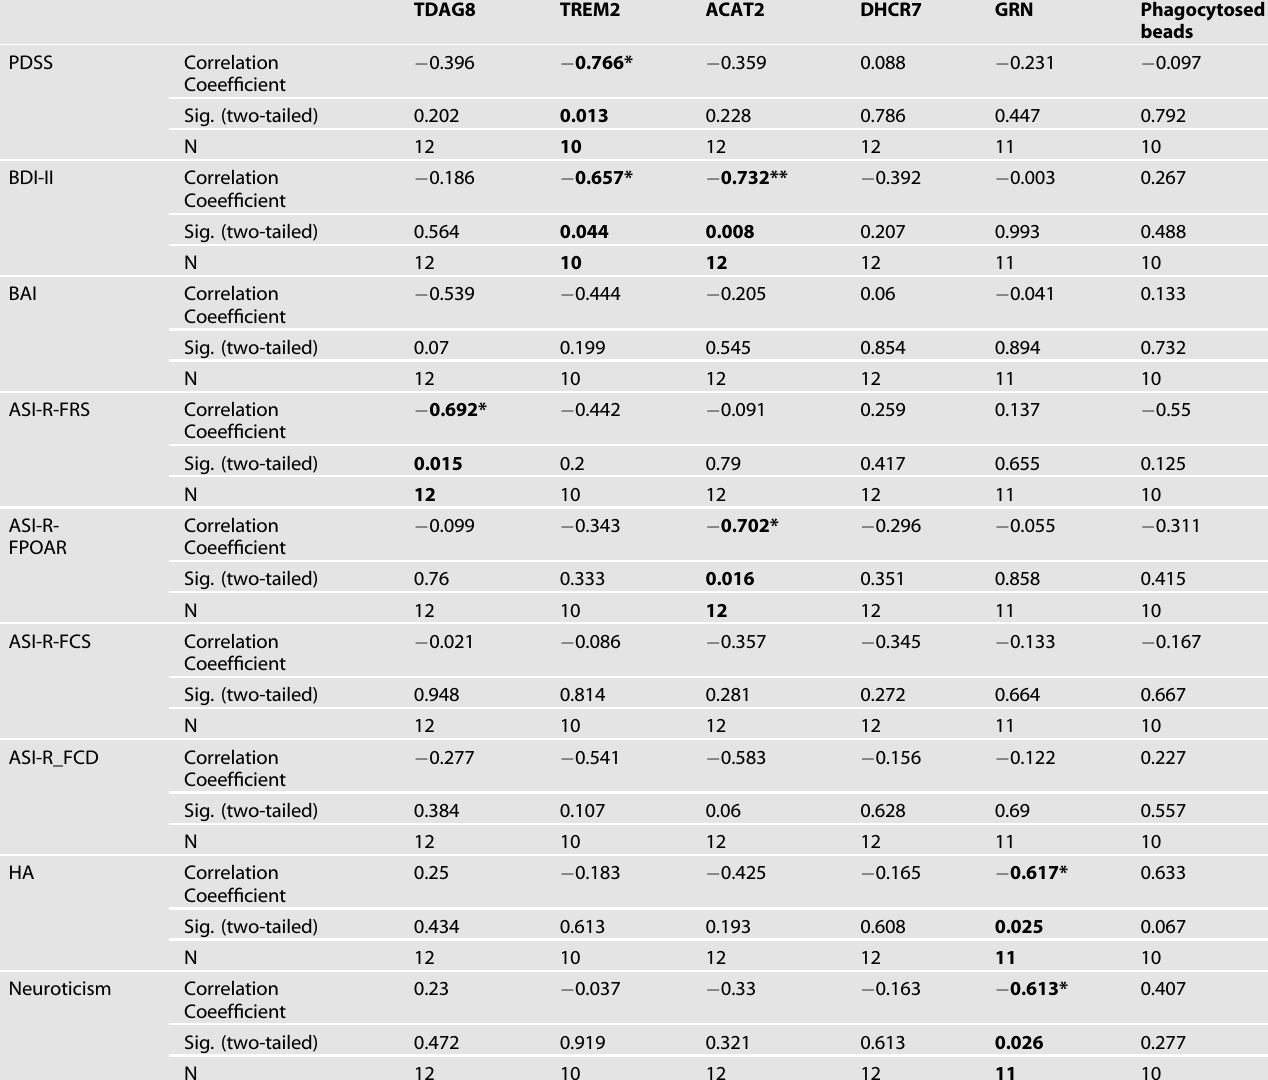
Table 1. Statistics of correlation analysis among the clinical indicators, gene expression levels, and phagocytic function.